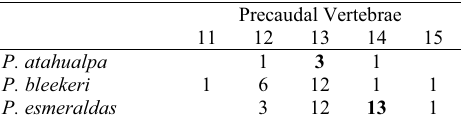
Table 27. Number of specimens of the species of Paracetopsis with cited number of precaudal vertebrae. Bold indicates val- ues for holotype when examined.